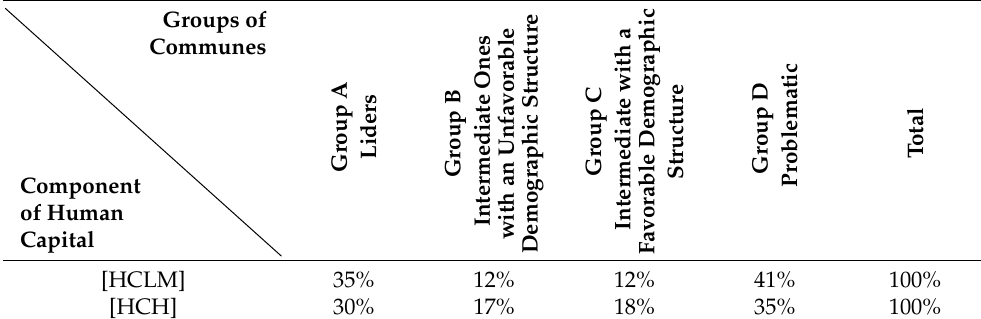
Table 7. Structure of communes in terms of the level of the measure [S-EDI] and individual compo- nents of human capital (in %). Effects of grouping